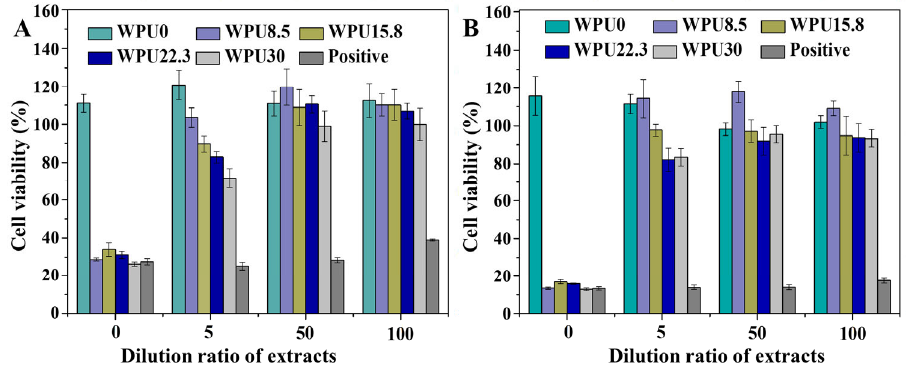
Figure 7. Cell viability of WPUn extracts with serial dilutions after 24 h ( A ) and 72 h ( B ) incubation. Error bars represent means ± standard deviation for n = 3. Statistical significance: p < 0.05.